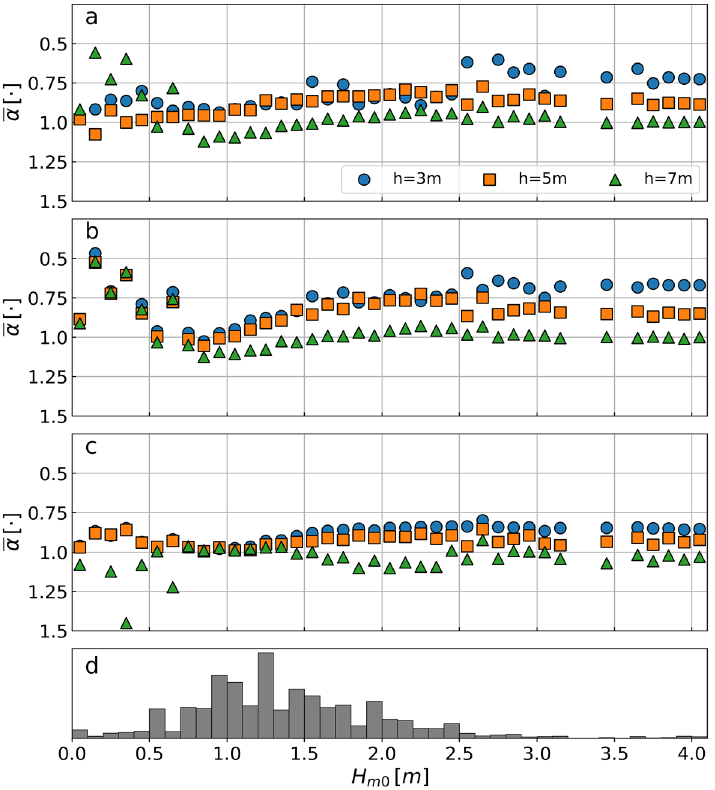
Figure 11. Relative integrated wave power binned by offshore wave height for Vilano Beach where the blue circles, orange squares, and green triangle markers represent the 3 m, 5 m, and 7 m placement depths, respectively. ( a ) Linear berm; ( b ) undulated berm; ( c ) discrete mounds; ( d ) probability density function for offshore wave height.